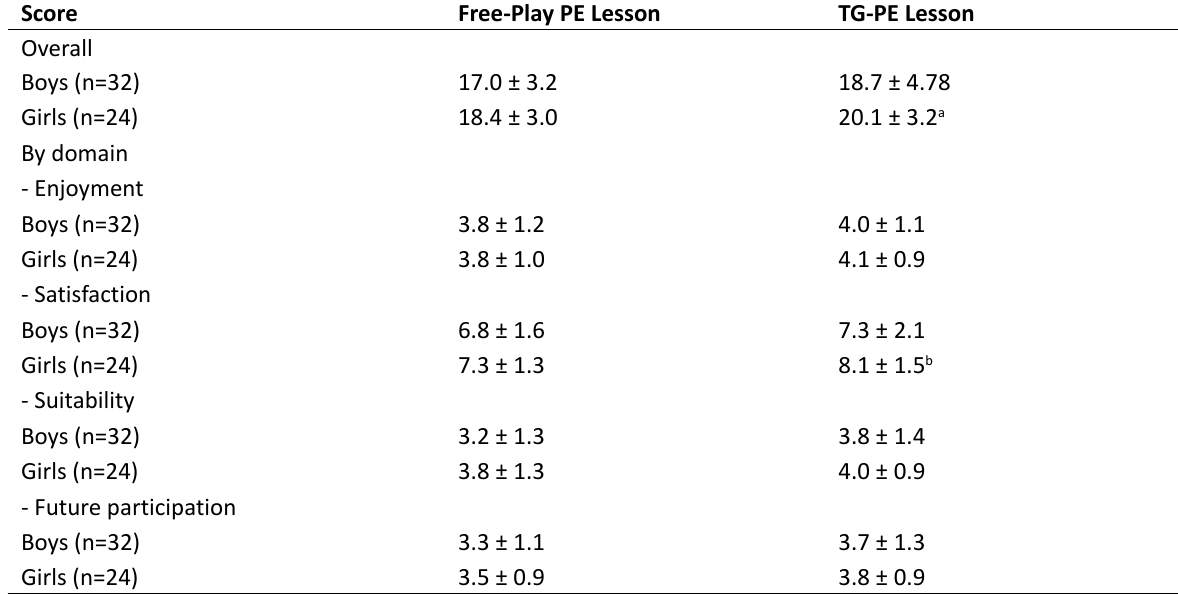
Table 5 . Comparison of Acceptance Score towards Free-Play PE Lesson and TG-PE Lesson across Gender (Mean ± SD)